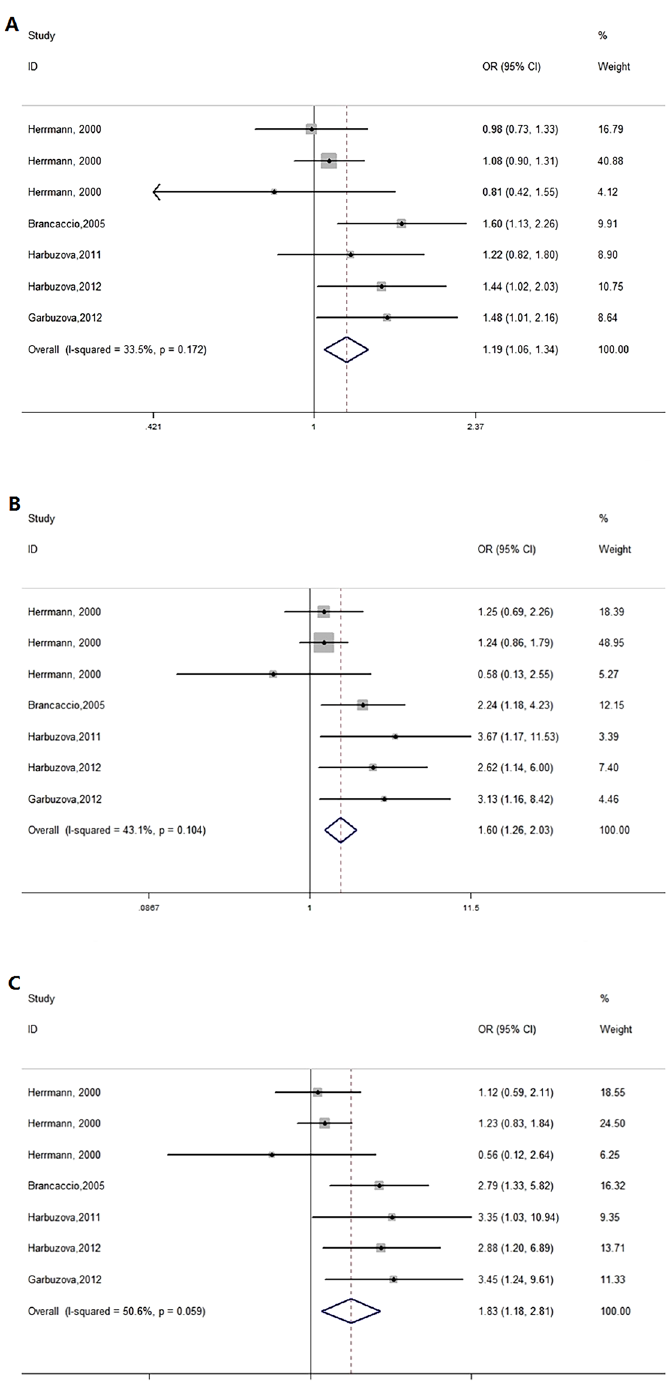
Figure 3. Forest plots of subgroup analyses in Caucasians, ( A ) allelic model; ( B ) recessive model; ( C ) homozygote